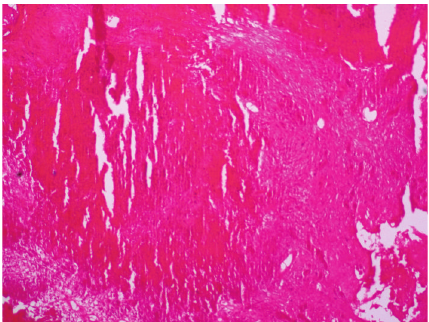
Figure 4: Photomicrograph of vertebral bone biopsy specimen showing caseating granulomas consistent with tuberculosis (hema- toxylin and eosin stain; 20 fold